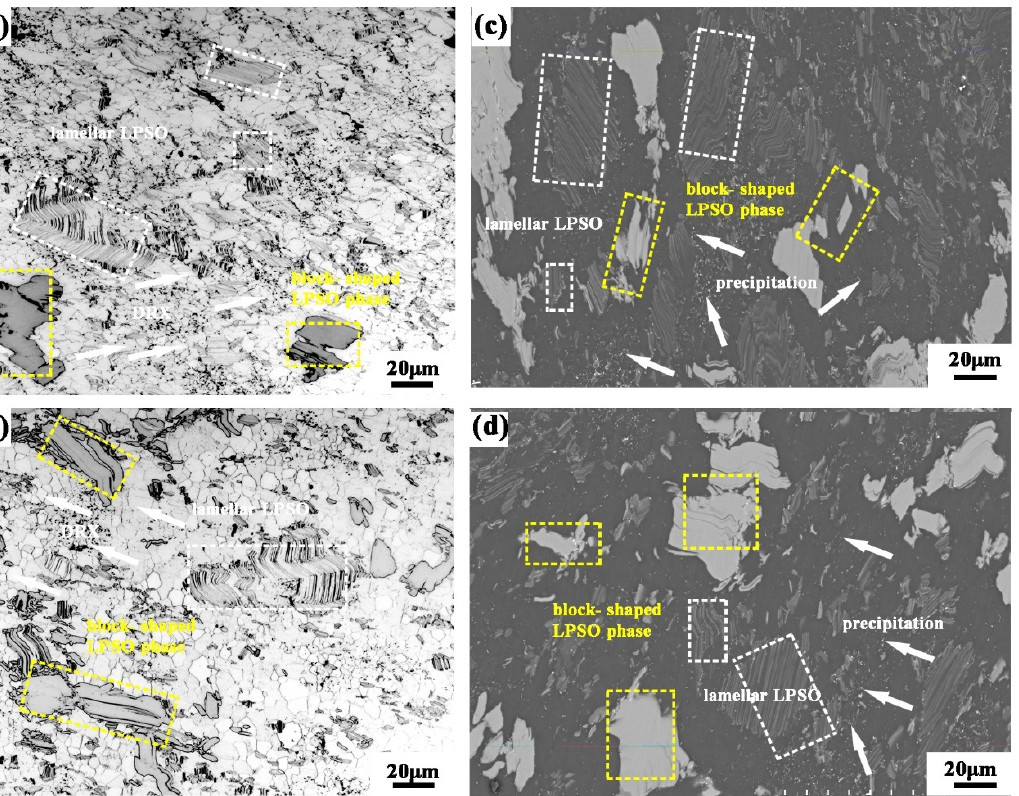
Figure 9. Microstructure evolution of deformed samples at a strain rate 0.5 s − 1 and at temperatures 653 K, and 743 K, respectively: ( a , b ) OM; ( c , d ) SEM maps (white and yellow square frame showed lamellar LPSO phase and block-shaped LPSO phase, respectively).